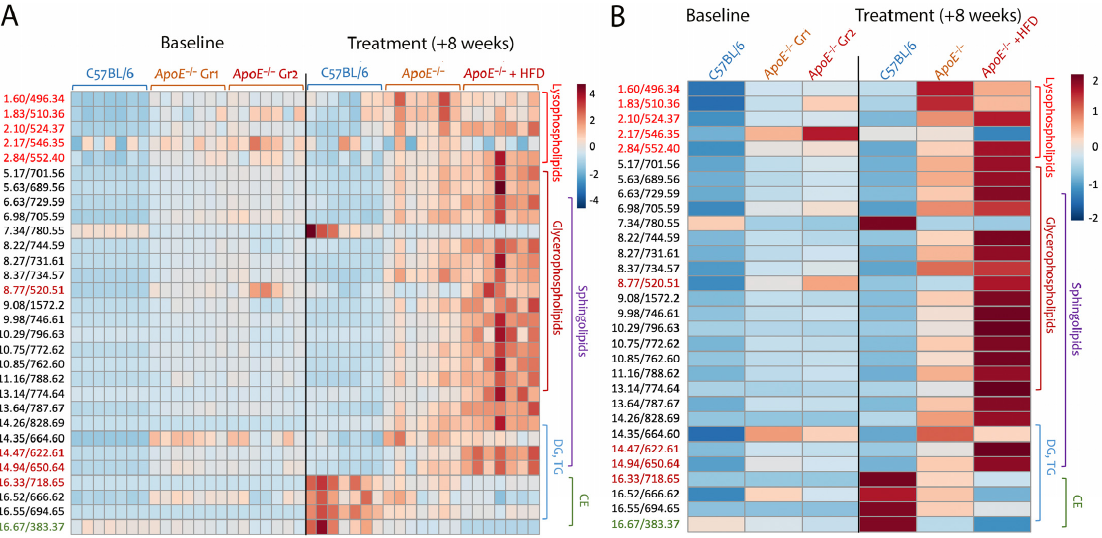
Figure A3. ApoE − / − mice fed with a high-fat diet showed higher SM and CER levels. Data was displayed in heatmaps ( A ) individually and (B) average of n = 7. We accessed the disease model’s trajectory using all of the lipid pro fi le data from mice plasma. Our fi ndings showed that apoE − / − mice had increased lysophospholipid levels regardless of whether they were fed NCD or HFD. LPC levels in apoE − / − mice were two to four times greater than in C57BL/6 mice, whether they were 8 or 16 weeks